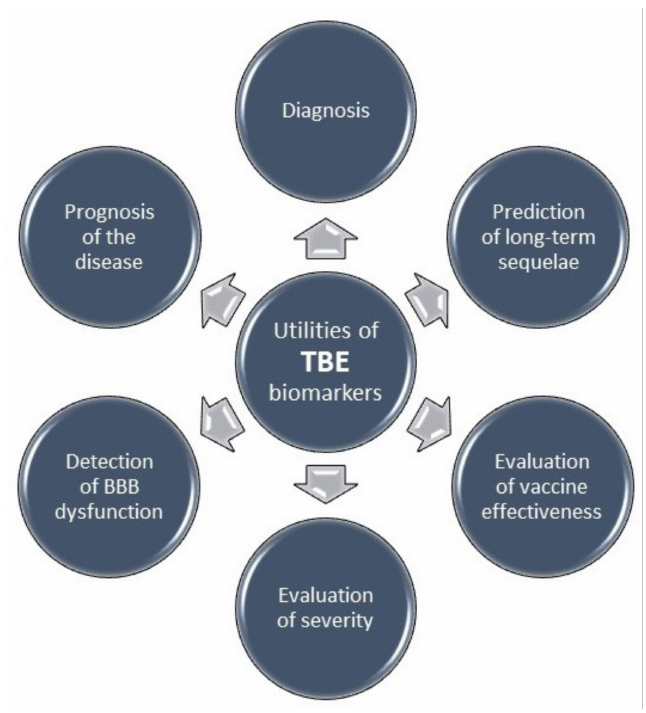
Figure 2. Utilities of TBE biomarkers. TBE, tick-borne encephalitis; BBB, blood–brain